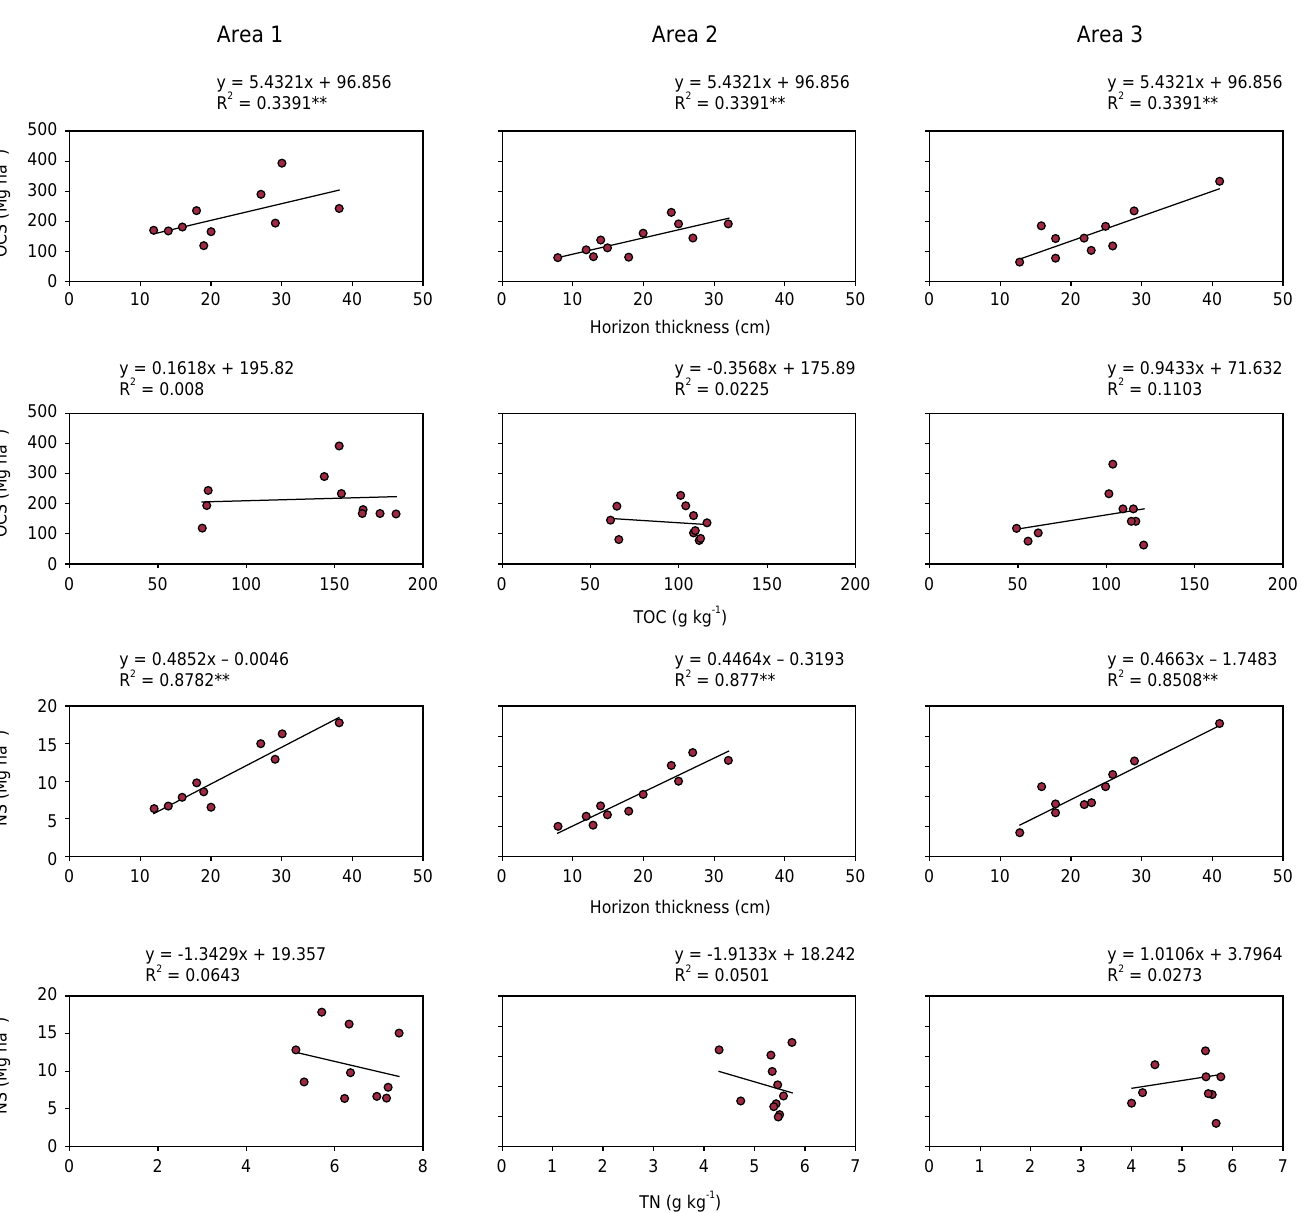
Figure 4. Relations between carbon and nitrogen stocks (OCS and NS) and horizons thickness and total carbon and nitrogen contents (TOC and TN). P1, P2, and P3: Area 1 - secondary tropical forest (natural vegetation); P4, P5, and P6: Area 2 - conventional tillage of cassava ( Manihot esculenta ); P7, P8, and P9: Area 3 - intercropped coconut ( Cocos nucifera ) with cassava ( Manihot esculenta